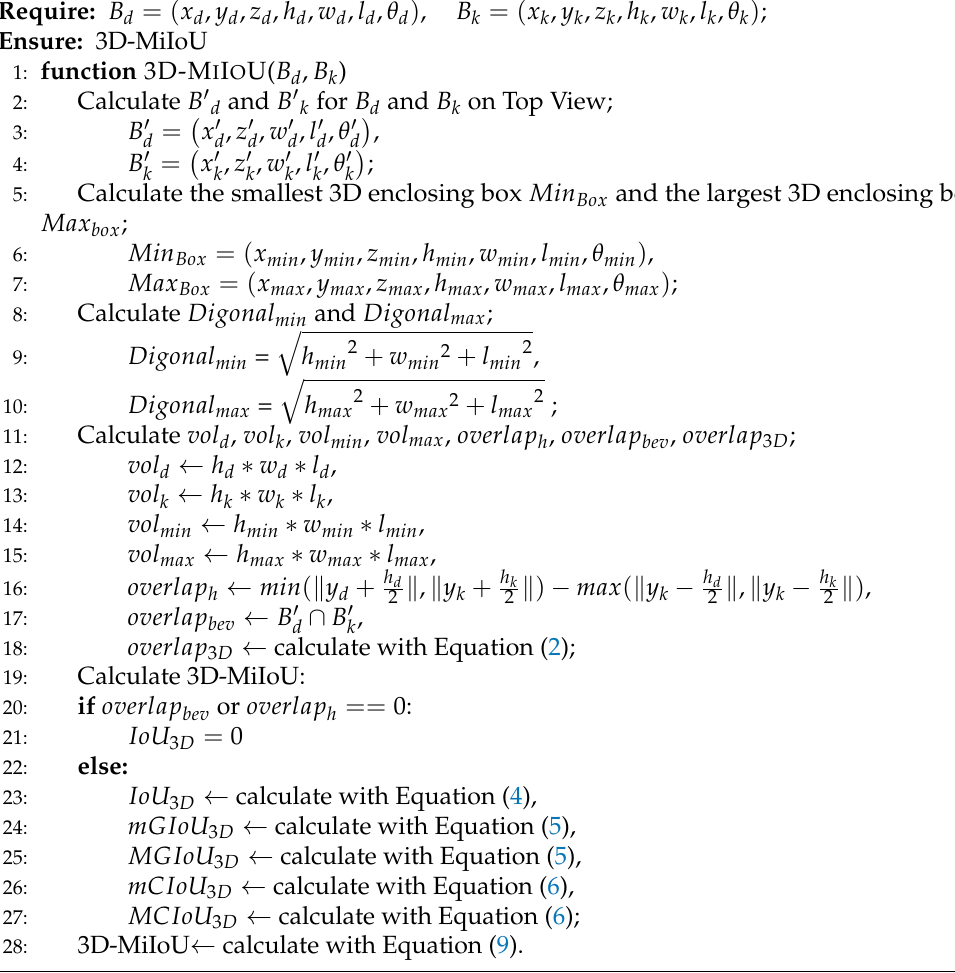
Algorithm 1 Three-dimensional mixed intersection over